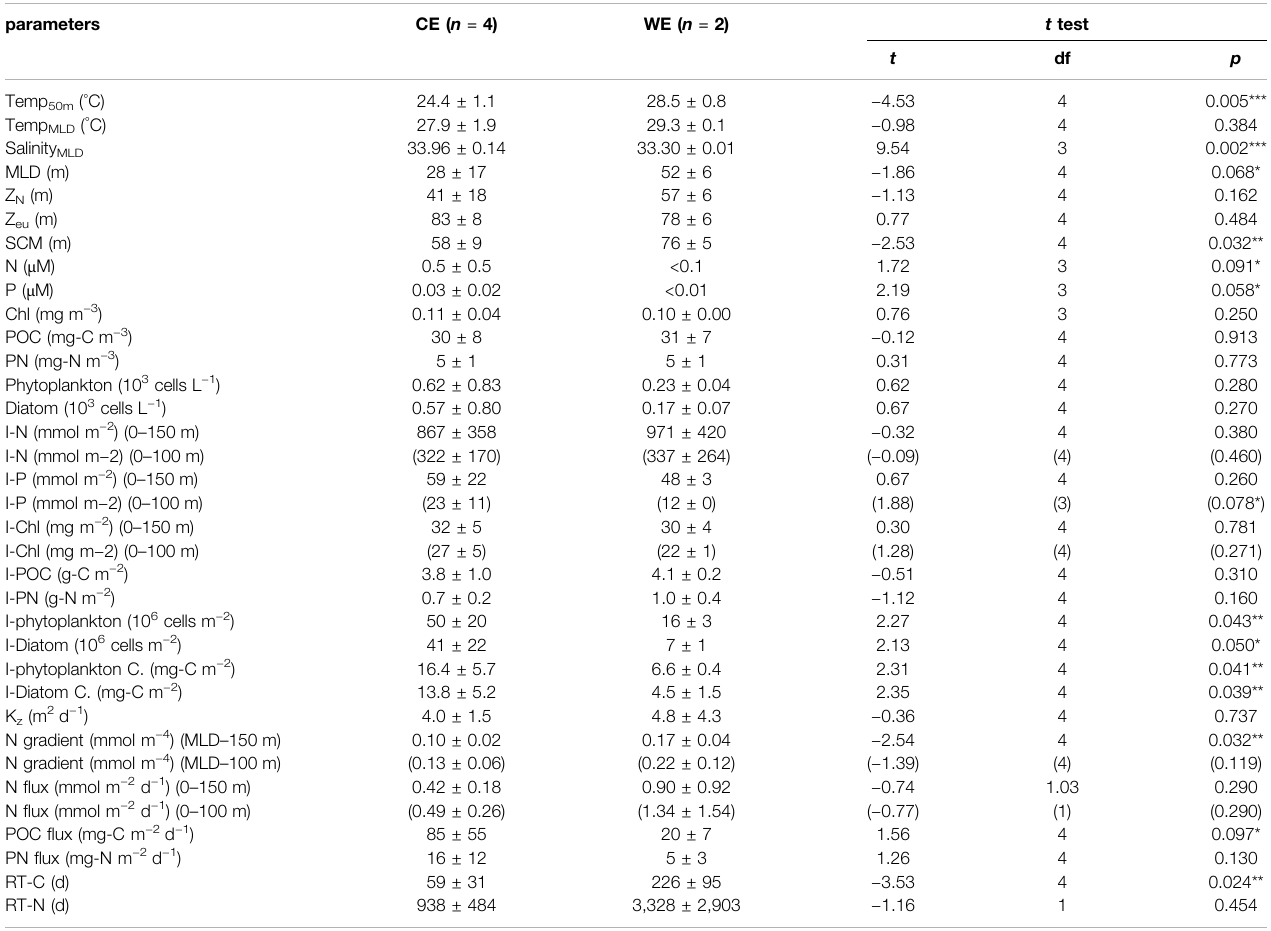
TABLE2| Summaryofthehydrographicandbiogeochemicalparameters( ± SD)measuredinthisstudyofthenorthernSouthChinaSea,includingthetemperaturesat50 m waterdepth(Temp 50m );meantemperatureandsalinityvaluesofthemixedlayer(Temp MLD andSalinity MLD );themixedlayer,nitracline,euphoticzoneandsubsurfaceChl maximum depths, respectively (MLD, Z N , Z eu and SCM); surface water concentrations of N, P, Chl, POC and PN, respectively (N, P, Chl, POC and PN); the surface abundances of large ( > 5 μ m) phytoplankton and diatoms (Phytoplankton and Diatom); water column inventories (0 – 150 and 0 – 100 m) of N, P and Chl (I-N, I-P and I-Chl); inventoriesintheupper150 mofPOCandPN(I-POCandI-PN);watercolumnphytoplanktonanddiatominventoriesintheupper100 m(I-PhytoplanktonandI-Diatom); water column phytoplankton and diatom carbon inventories in the upper 100 m (I-Phytoplankton C. and I-Diatom C.); the values of diffusion coef fi cient (K z ); the vertical gradients (MLD – 150 and MLD – 100 m) of N (N-gradient); the upward vertical diffusive fl uxes (0 – 150 and 0 – 100 m) of N (N fl ux); export fl uxes of POC and PN at 150 m depth (POC fl ux and PN fl ux); retention times of C and N in the upper 150 m (RT-C and RT-N).